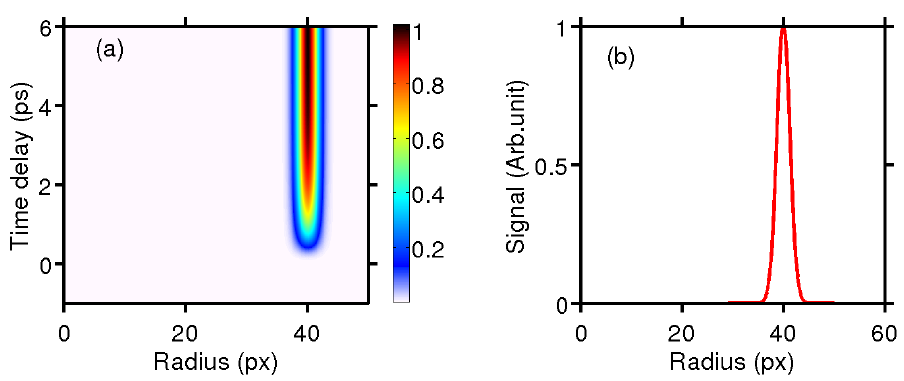
Figure 3. ( a ) 2D representation of the signal shown in Figure 2 angularly integrated as a function of radius and time; ( b ) velocity distribution (in pixels of the CCD camera) extracted from ( a ) at a fixed delay time of 5